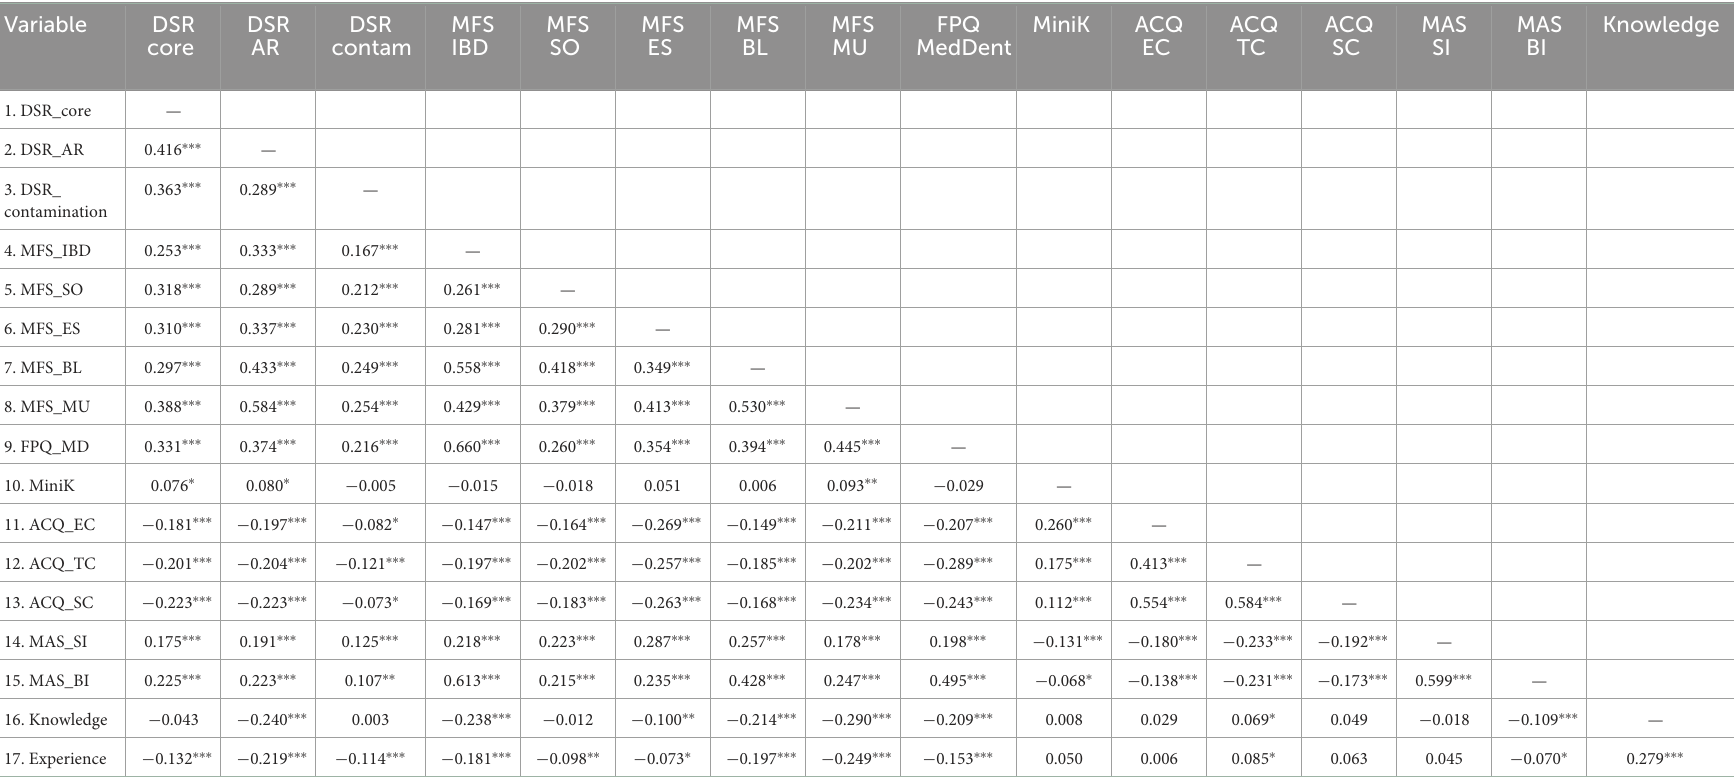
TABLE 3 Pearson correlational coefficients between all variables used in the structural equation